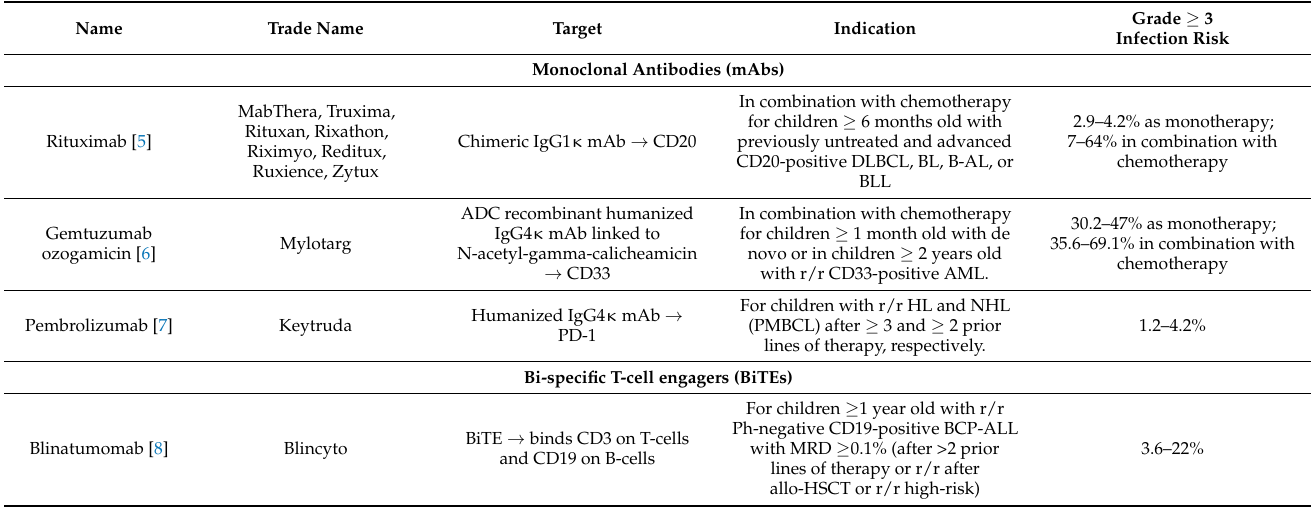
Table 1. FDA and EMA approved targeted therapies for childhood leukemias and